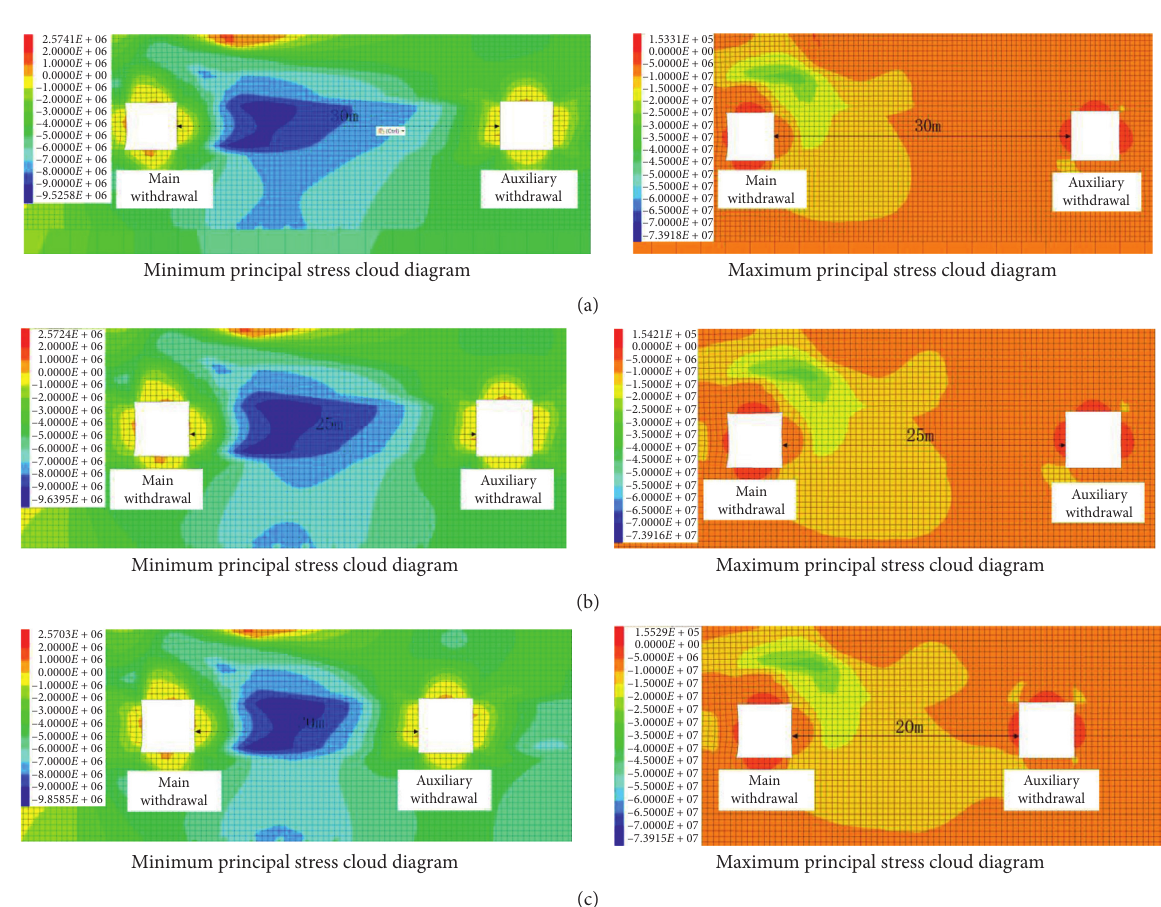
Figure 17: Maximum and minimum principal stress cloud diagram when Panel 31113 is 5m from penetration. (a) Main and auxiliary withdrawal spacing � 30 m. (b) Main and auxiliary withdrawal spacing � 25 m. (c) Main and auxiliary withdrawal spacing � 20m.